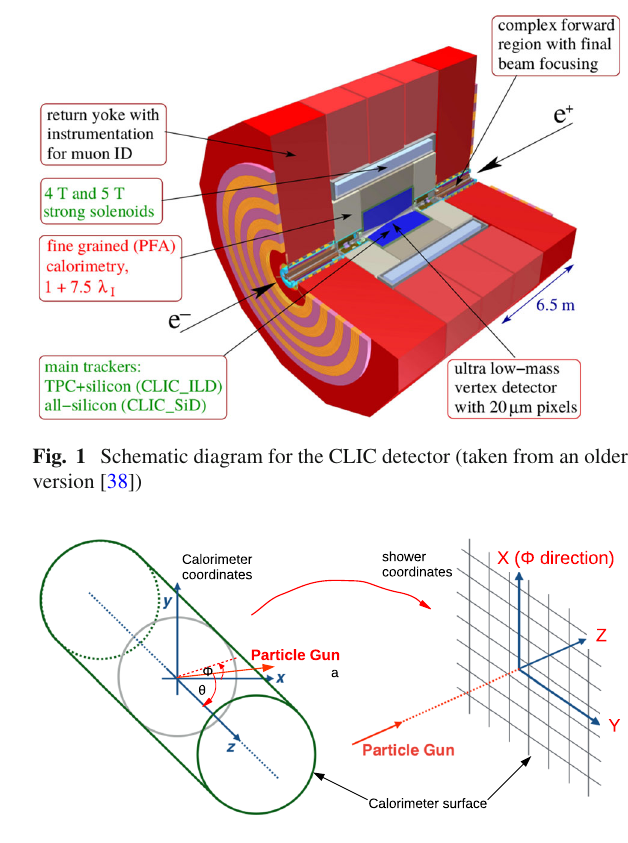
Fig. 2 The calorimeter barycenter computation was done in global coordinates(left)andthecellsweresavedbasedonthelocalcoordinates (right)